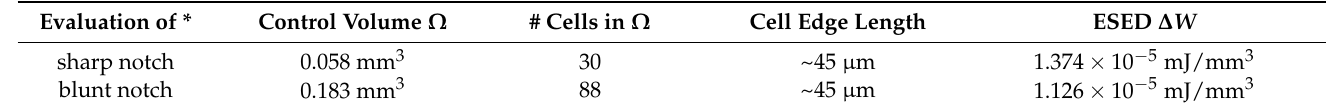
Table 8. Evaluated elastic strain energy density by manual partitioning of the control volume